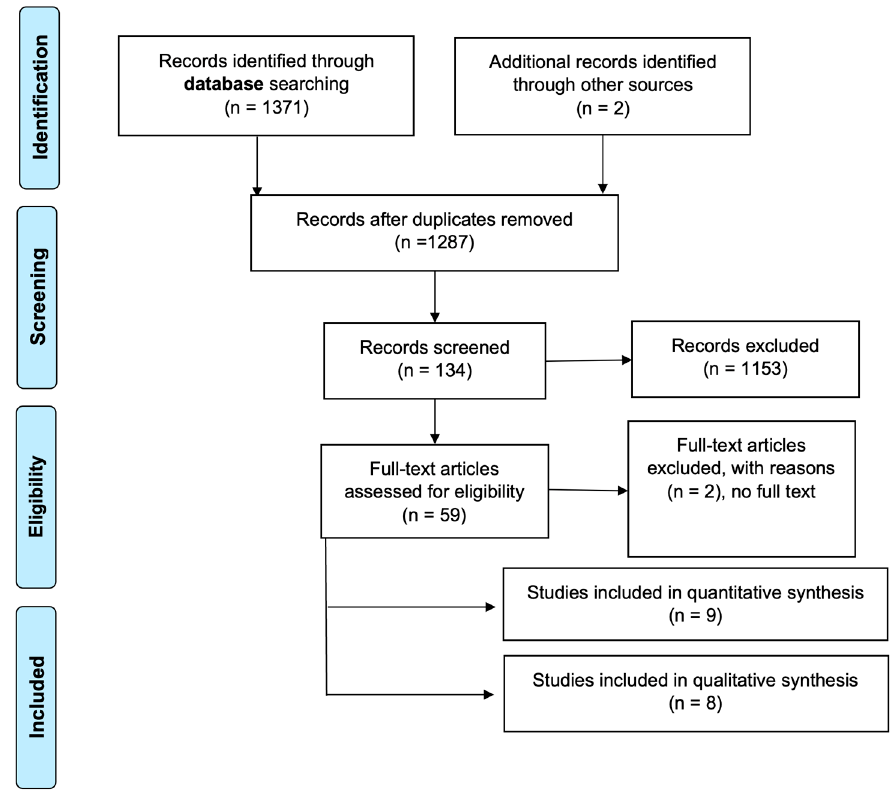
Figure 1. PRISMA flowchart.